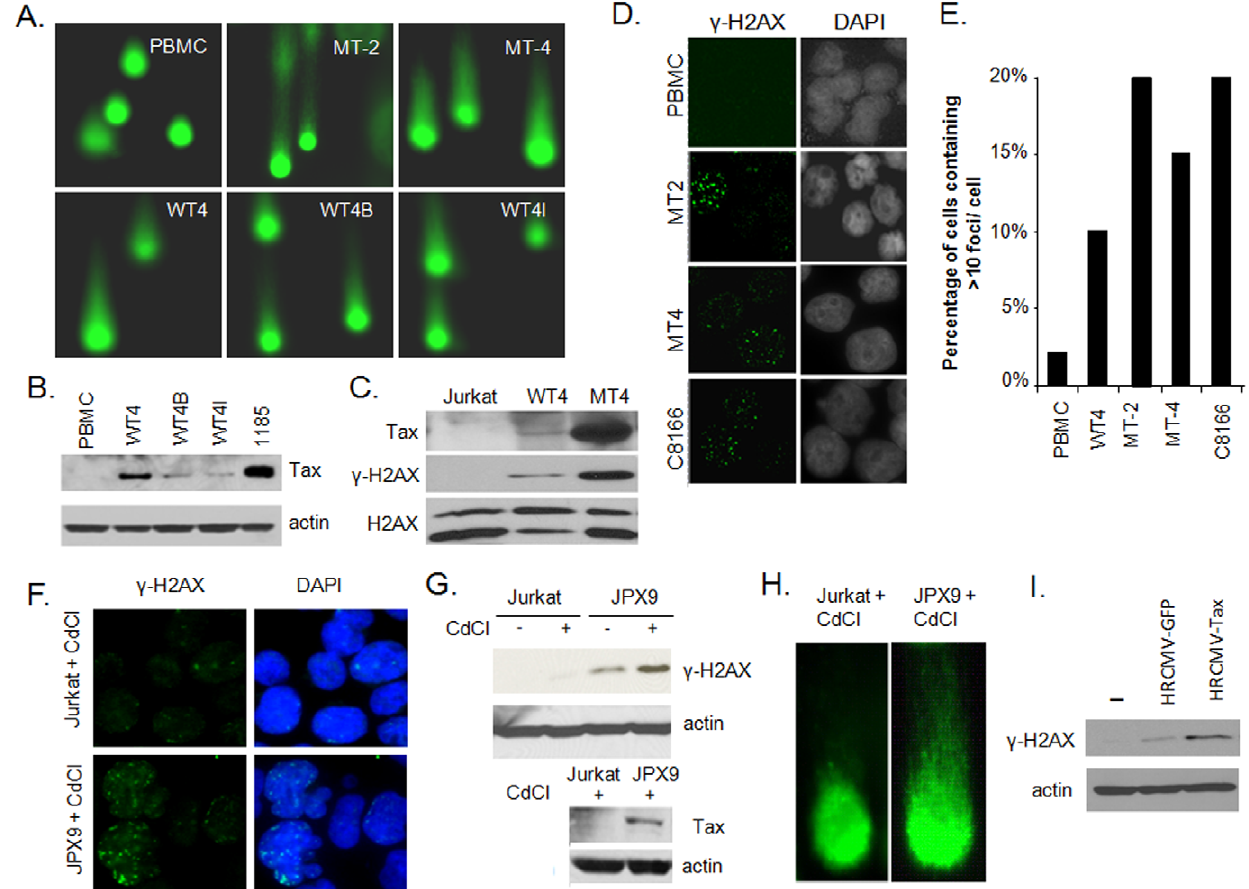
Figure 1. HTLV-I Tax stimulates the formation of DDSB in the genome. A) Accumulation of DDSB in HTLV-I-transformed cells MT-4 and Tax- only immortalized human T cells WT4, WT4I and WT4B was analyzed by comet assays. Normal PBMCs were used as a negative control. B) Western blots analyses showing physiological levels of Tax expression in human T-cell lines immortalized by Tax only. C) Western blot analyses for c -H2AX and Tax expression in HTLV-I-transformed MT-4 cells, Tax-immortalized WT-4 T-cells or Jurkat control cells. H2AX was used as a loading control for each sample. D) c -H2AX foci were readily detected by immunofluorescence in HTLV-I transformed cells and Tax-expressing T-cells but not in normal PBMCs. E) Quantification of the percentage of cells harboring 10 or more c -H2AX foci per cell in PBMC, WT-4, MT-4, MT-2 and C8166. Results were derived from counting 100 nuclei for PBMC and each cell line. F) Tax-inducible Jurkat JPX9 cells and Jurkat control cells were treated with CdCl to induce Tax expression in the former and analyzed by immunofluorescence for presence of DDSB as shown by c -H2AX foci. G) Western blot analyses using c -H2AX and Tax-specific antibodies confirmed an increased c -H2AX expression in Tax-expressing cells only. H) Representative image of DDSB detected by comet assays in JPX9 cells only after induction of Tax and not Jurkat cells treated under the same conditions. I) Jurkat cells were transduced with VSV-pseudotype viruses expressing Tax or GFP as described in materials and methods. After 48 hours proteins were extracted and analyzed by western blot for c -H2AX expression. Actin was used as a loading